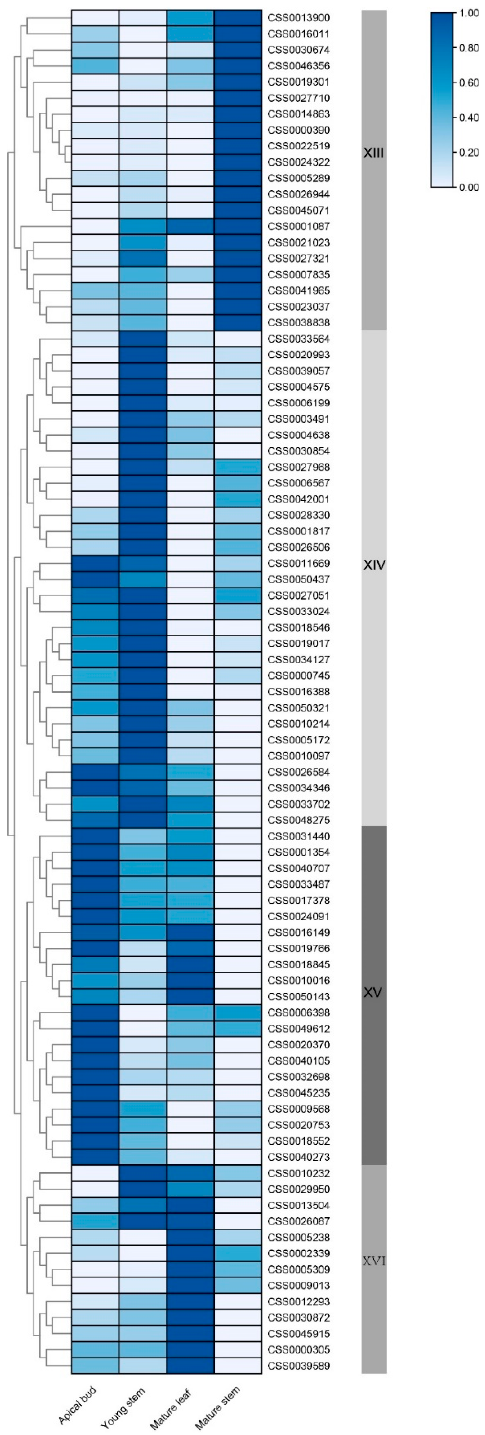
Figure 7. Expression profile of CsC2H2-ZFP in different tissues. The heatmap was visualized using log transformed values by TBtools software. The expression data from RNA-seq was used to generate the heatmap by TBtools. The dark blue and light blue indicate high and low level of gene expression, respectively.